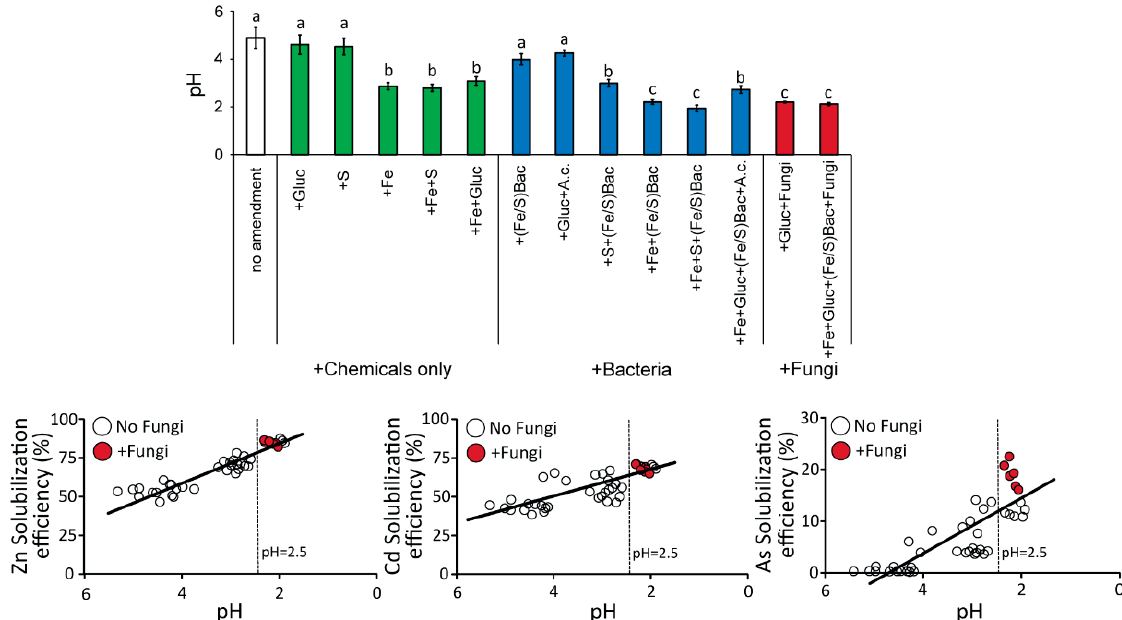
Figure 4. Sediment pH values among experimental treatments and controls at the end of the incubation period and their correlation with HM solubilization efficiency. In the upper panel, reported are average sediment pH values and SDs. In the lower panel, reported are the relationships between the Zn, Cd, or As solubilization efficiency and sediment pH, with the white dots indicating overall treatments without fungal additions and red dots representing the overall treatments with the addition of fungi. Different letters in the upper bar chart highlight significant differences among values.